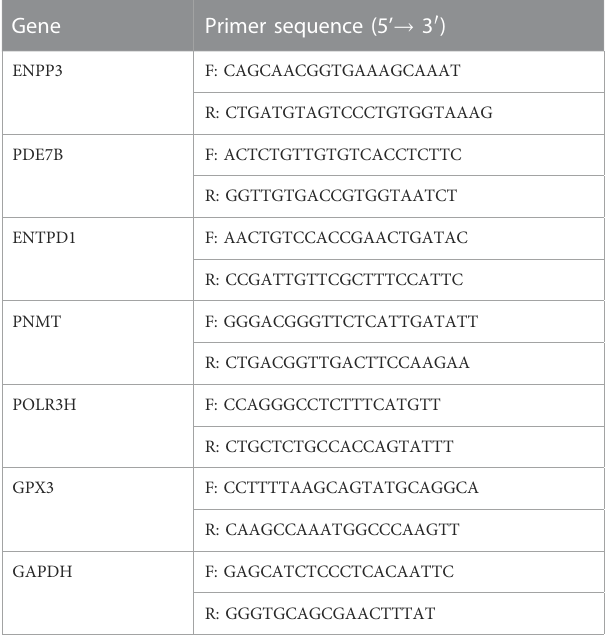
TABLE 2 qRT-PCR primer